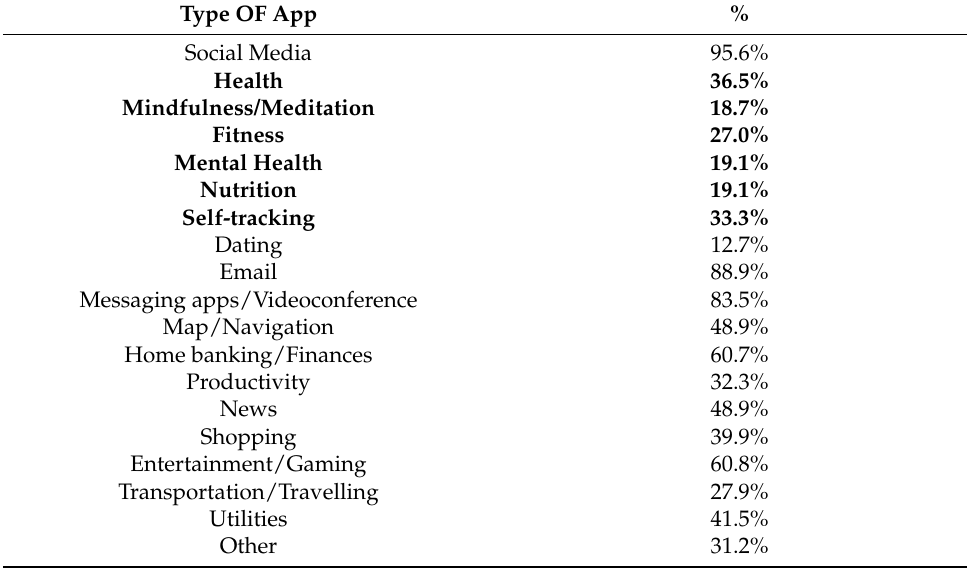
Table 2. Types of apps and corresponding percentages of highly frequent usages.